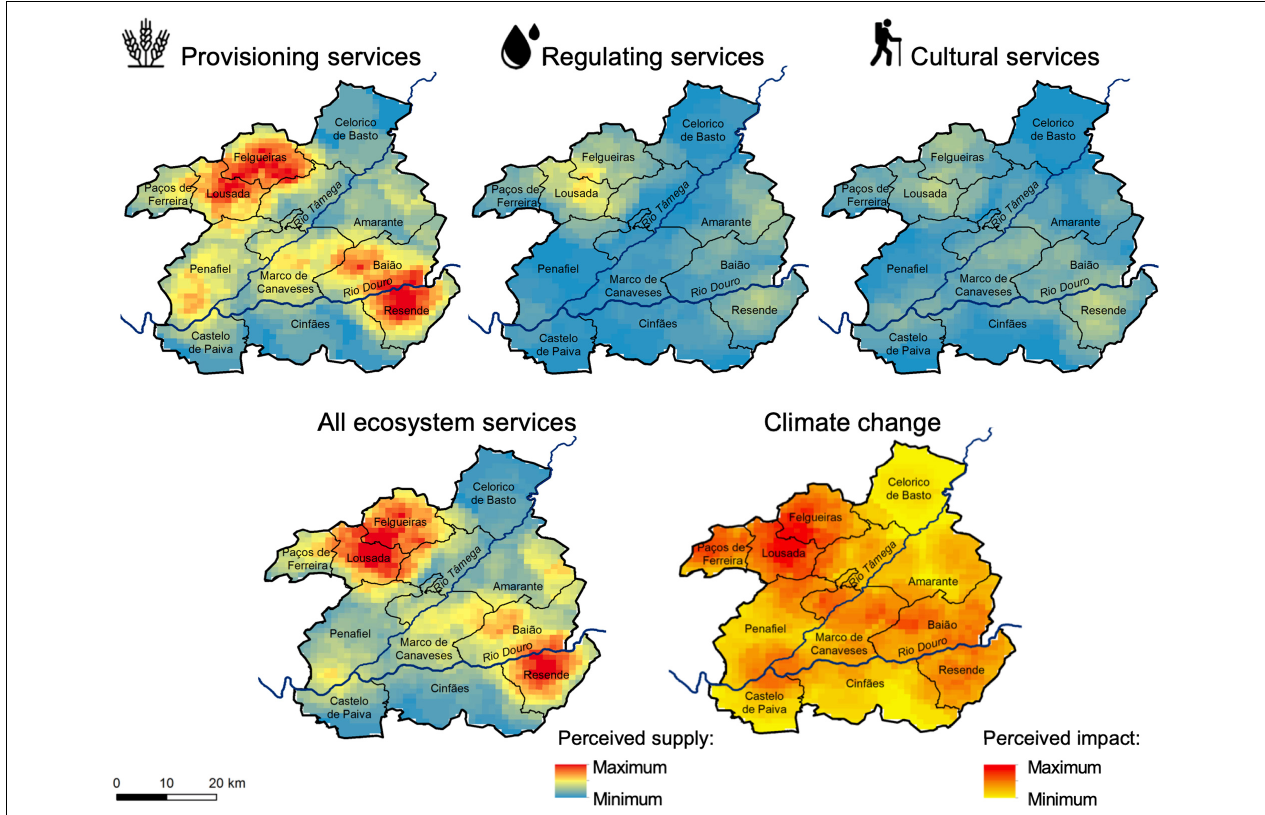
FIGURE 4 | Distribution of the areas of supply of provisioning, regulating and cultural ecosystem services as mapped by the public officers (at the top). The figure also shows the areas of supply of all ecosystem services alongside the perceived distribution of future climate impacts (at the